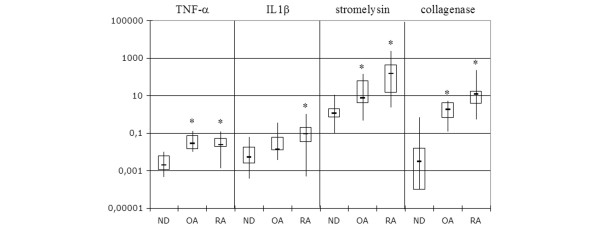
Expression of TNF-α, IL-1β, stromelysin and collagenase I in synovial tissues. Results are presented as percentage of GAPDH expression on a logarithmic scale with maximum, minimum, quartiles and median. Where indicated with an asterisk, there were significant differences from normal tissues (p < 0.05; Mann–Whitney). Rheumatoid arthritis (RA) versus normal donors (ND): IL-1β, p = 0.0097; TNF-α, p = 0.008; stromelysin, p = 0.0009; collagenase I, p = 0.0002. Osteoarthritis (OA) versus ND: IL-1β, p = 0.1451; TNF-α, p = 0.0013; stromelysin, p = 0.038; collagenase I, p = 0.0012. RA versus OA: IL-1β, p = 0.0397; TNF-α, p = 0.9591; stromelysin, p = 0.0124; collagenase I, p = 0.0266. GAPDH, glyceraldehyde-3-phosphate dehydrogenase.